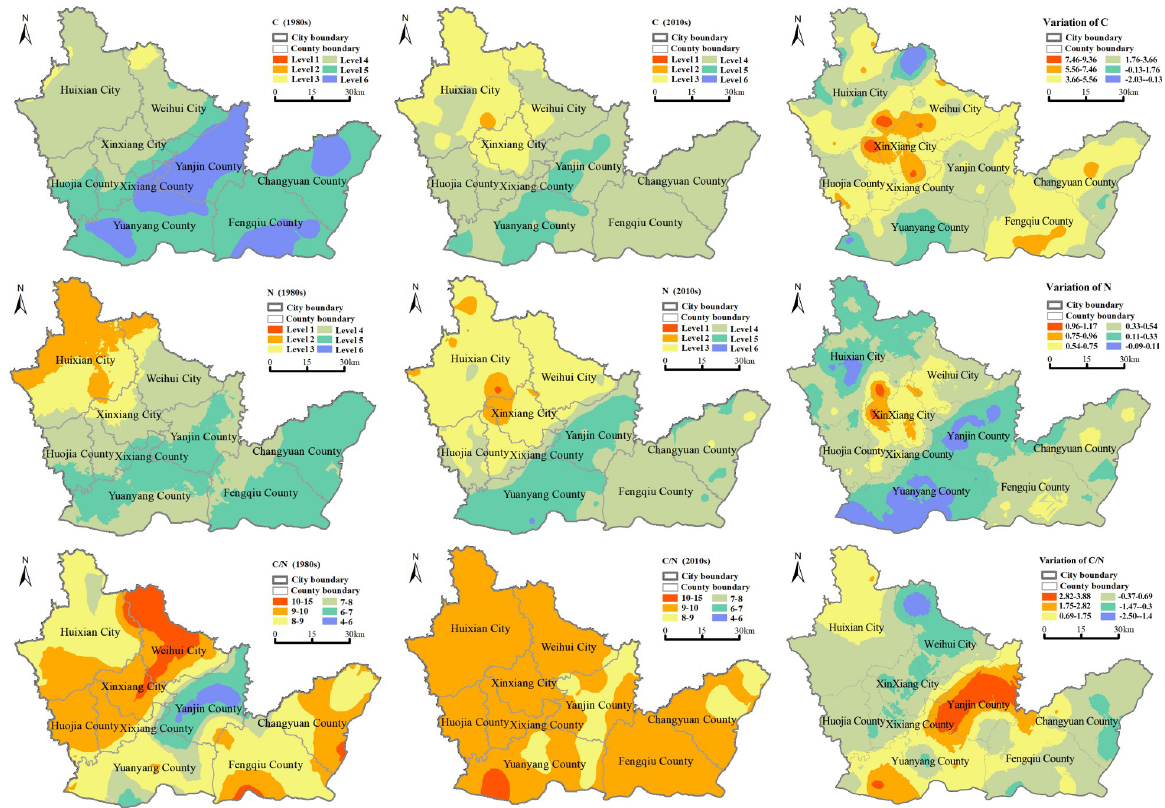
Fig 2. Spatial distribution and variation of C, N contents and C:N stoichiometry in the 1980s and the 2010s.